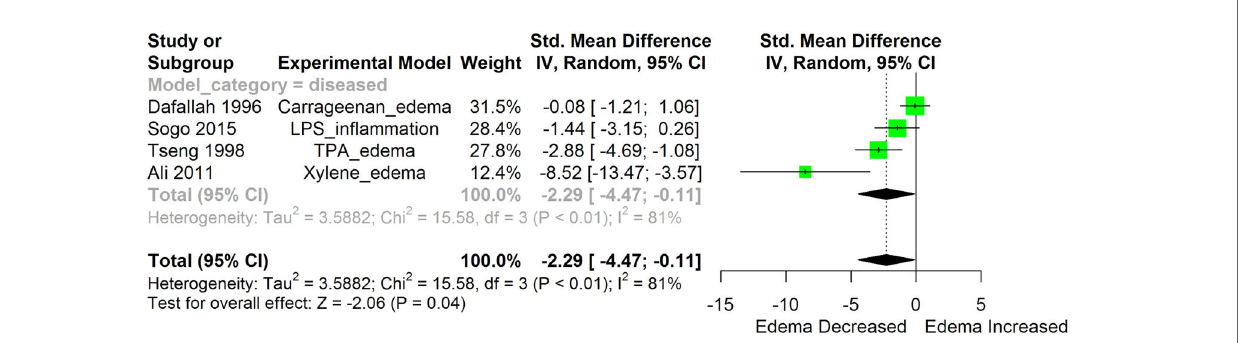
FIGURE 4 | Meta-analysis and forest plot of the effect of HS administration on Edema formation. The meta-analysis was sub-grouped by health status (i.e diseased or healthy state). The standardized mean difference (SMD), which is an estimate of the effect size, is presented as a square on the forest plot, for each study and as a diamond for the pooled estimate of each subgroup or overall studies. The overall pooled SMD for all included studies is shown in the bottom section of the forest plot. SMD data points that are lower than zero signify that treatments with HS lowered the level of the biomarker while those greater than zero signify that HS treatment causes an increase in the levels of the biomarker. The statistical signi fi cance of the pooled estimate is indicated by the Z test of signi fi cance. LPS, Lipopolysaccharide; TPA, 12-O-tetradecanoylphorbol-13-acetate.